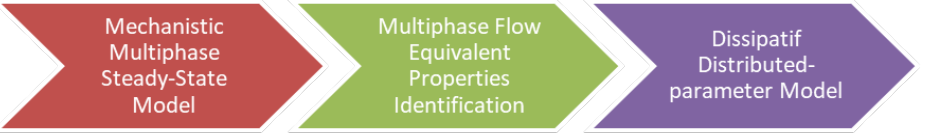
Figure 1. Multiphase flow reduced-order model structure.